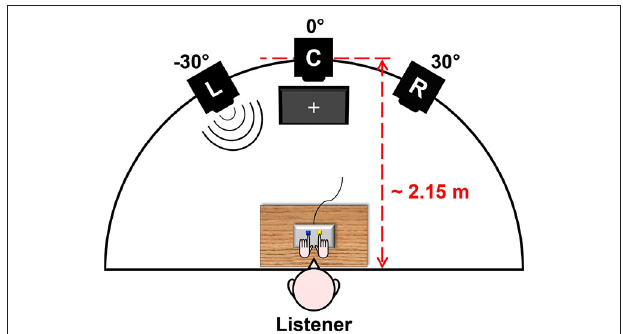
FIGURE 1 | Test layout deployed in the present study. The listener sits at a table, facing an array of three left (L), central (C), and right (R) loudspeakers (L = − 30 ◦ , C = 0 ◦ , R = 30 ◦ azimuth) at a distance of approximately 2.15 m. The listener responds to stimuli by pressing keys on a response pad, while fixating a white cross displayed on a monitor screen below C. This figure originally appeared in Uhrig et al. (2020a), copyright 2020, with permission from